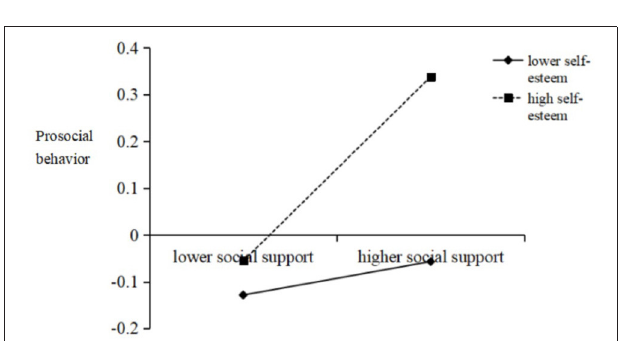
FIGURE 4 | Interaction effect of social support and self-esteem on prosocial behavior. High and low levels of social support and self-esteem represent one standard deviation above and below the mean,